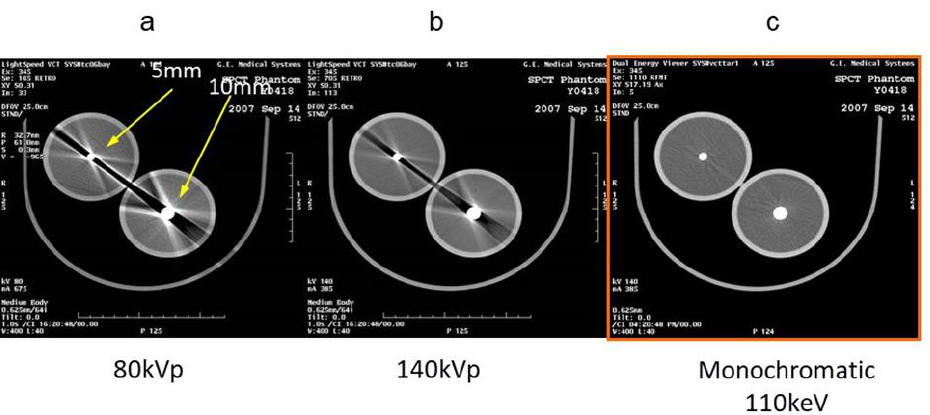
Figure 3. Beam-hardening artifact of the metal phantom using conventional multicolor X-ray CT imaging and virtual monochromatic imaging. Conventional polychromatic X-ray CT images ( a , b ), and tube voltages are 80 and 140 KVp. Beam-hardening artifacts derived from metal are observed especially at low-tube currents. ( c ) Virtual monochromatic image at 110 keV on dual-energy CT image, beam-hardening artifact, and CT value around metal are suppressed.